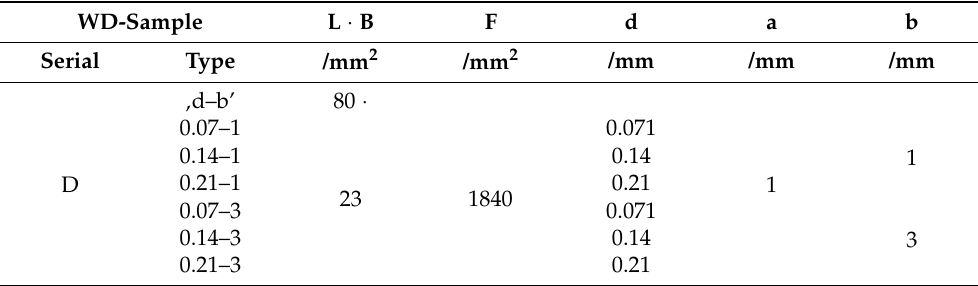
Table 1. List of dressing samples manufactured and measured, with their characteristic structural